Question: What visual encoding does this figure use to show its data?
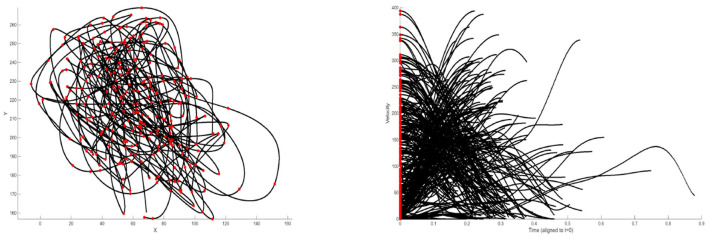
Answer: line